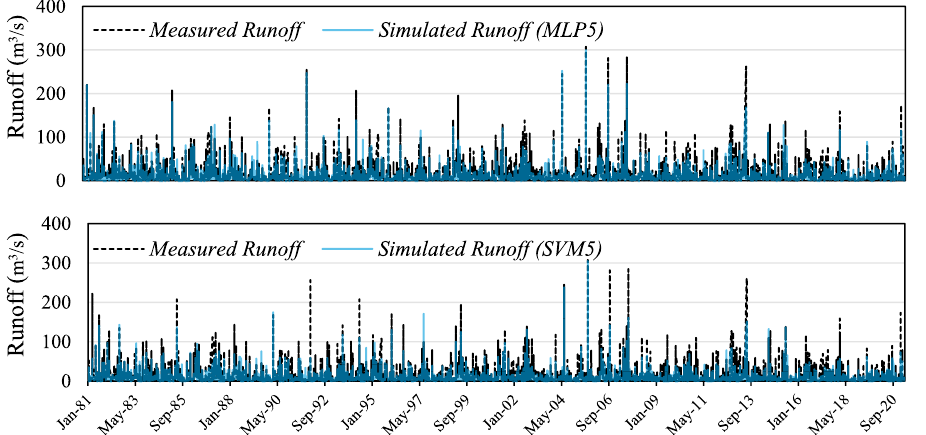
Figure 8. The plot of measured vs simulated runoff time series using MLP5 and SVM5 models.